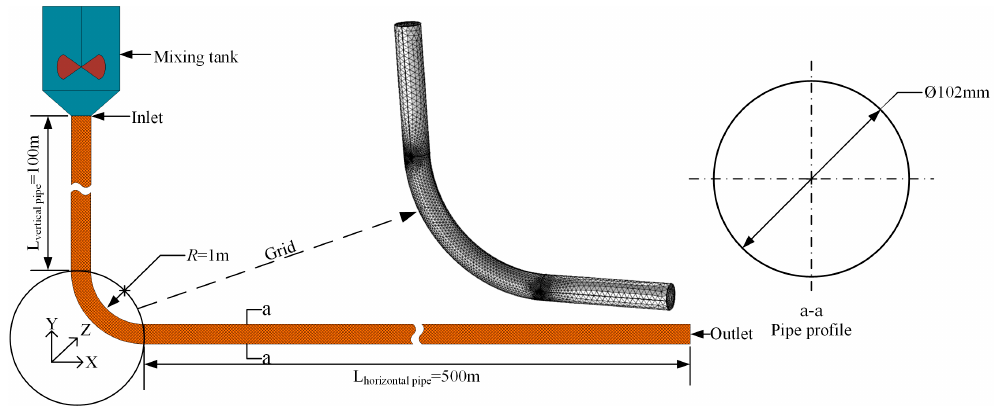
Figure 2. Pipeline transport system for backfill in an underground mine.